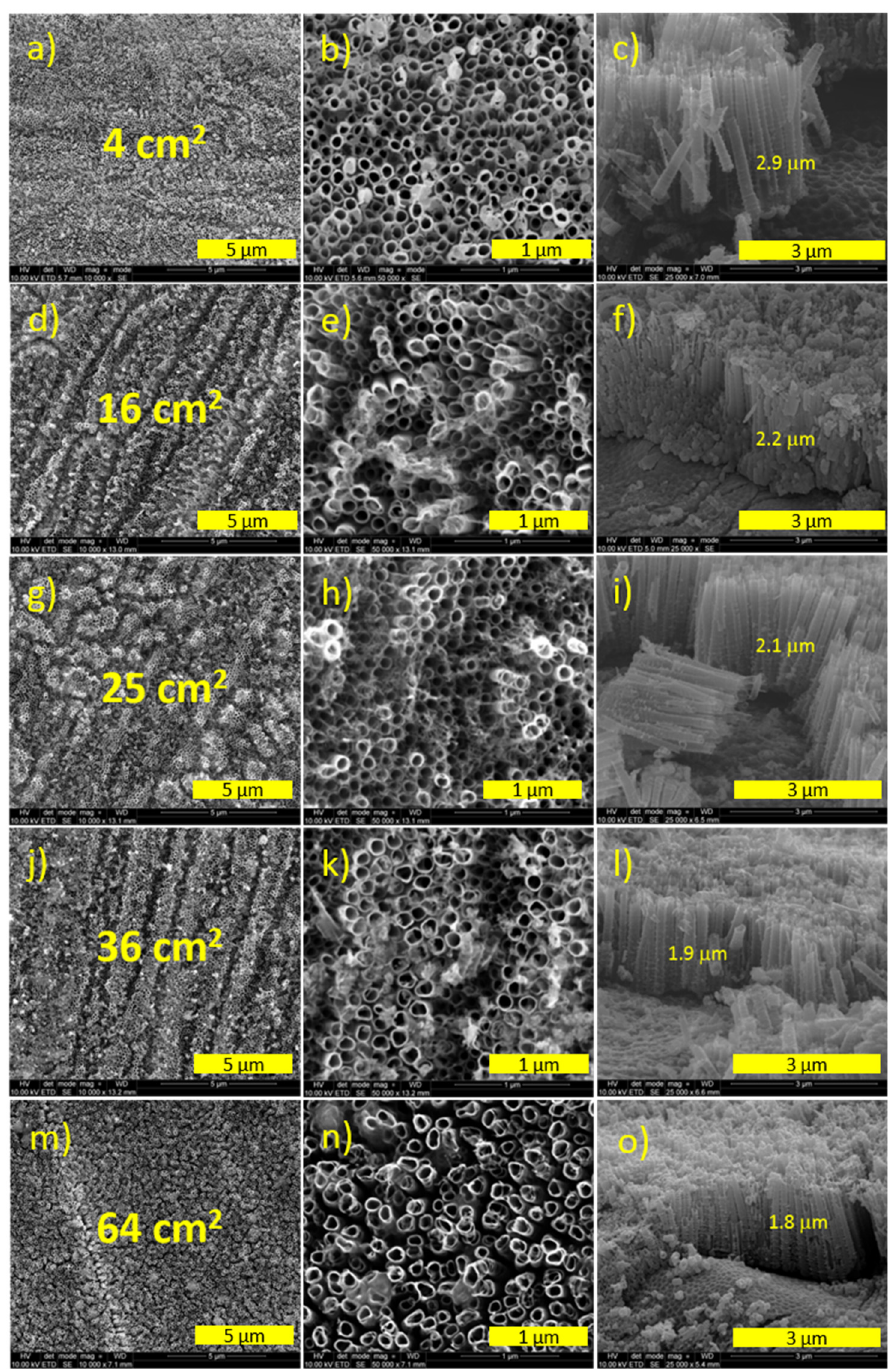
Figure 2. SEM images for TiO 2 nanotubes depending on size: ( a – c ) 4 cm 2 , ( d – f ) 16 cm 2 , ( g – i ) 25 cm 2 , ( j – l ) 36 cm 2 and ( m – o ) 64 cm 2 .